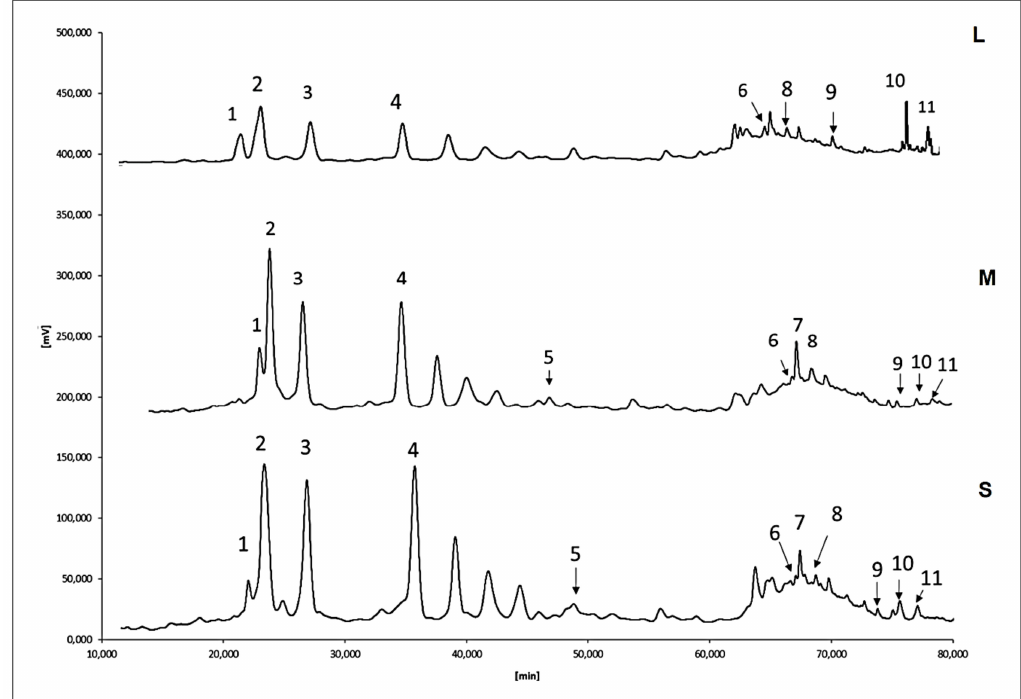
Figure 1. Individual phenolics identified avocado peel extracts (APEs) from small (S), medium (M), and large (L) fruit. The number on each peak represents 1—( + )-catechin hydrate; 2—ca ff eic acid; 3—( − )-epicatechin; 4—coumaric acid; 5—ferulic acid; 6—( ± )-naringenin; 7—naringin; 8—rutin hydrate; 9—quercetin; 10—hesperidin;